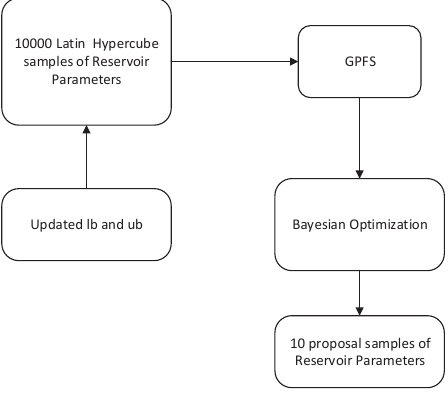
Figure 2. Flowchart of the GPFS for assisted history